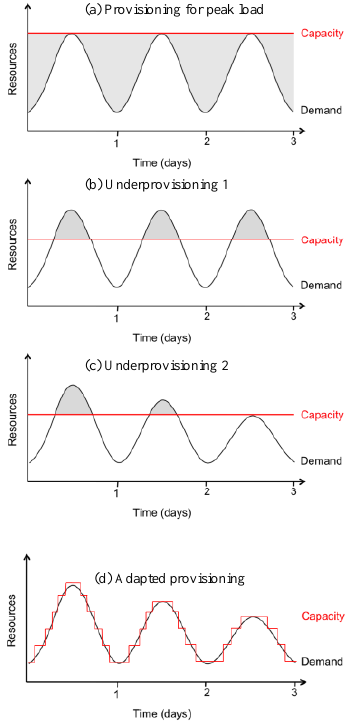
Figure 2. Schema of possible provisioning of hardware resources (modified after Armbrust